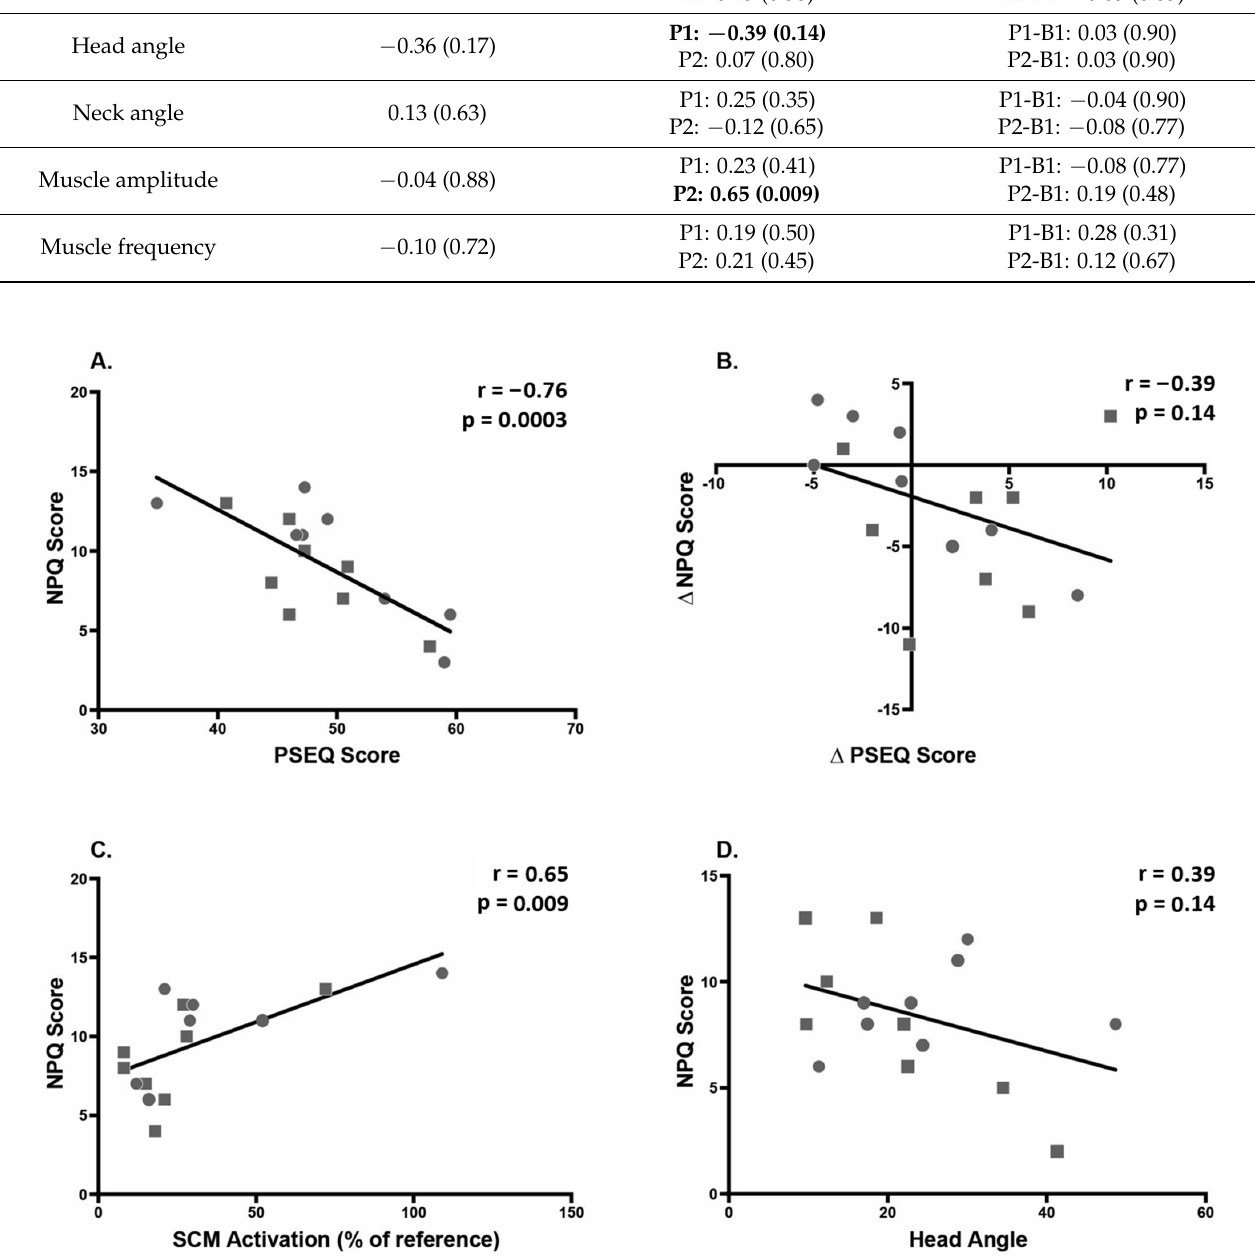
Figure 8 . Correlations between predictor variables and neck pain (NPQ score). Squares indicate Alexander group; circles indicate exercise group. ( A ) Correlation between pain self-efficacy (PSEQ) and neck pain at 2nd post-test, indicating that higher self-efficacy is associated with lower pain. ( B ) Correlation between change in pain self-efficacy (PSEQ) and change in neck pain between Baseline and 2nd post-test, indicating that a decrease in neck pain is associated with an increase in self-efficacy. ( C ) Correlation between sternocleidomastoid (SCM) activation and neck pain at 2nd post-test. ( D ) Correlation between head angle and neck pain (NPQ) at 1st post-test.